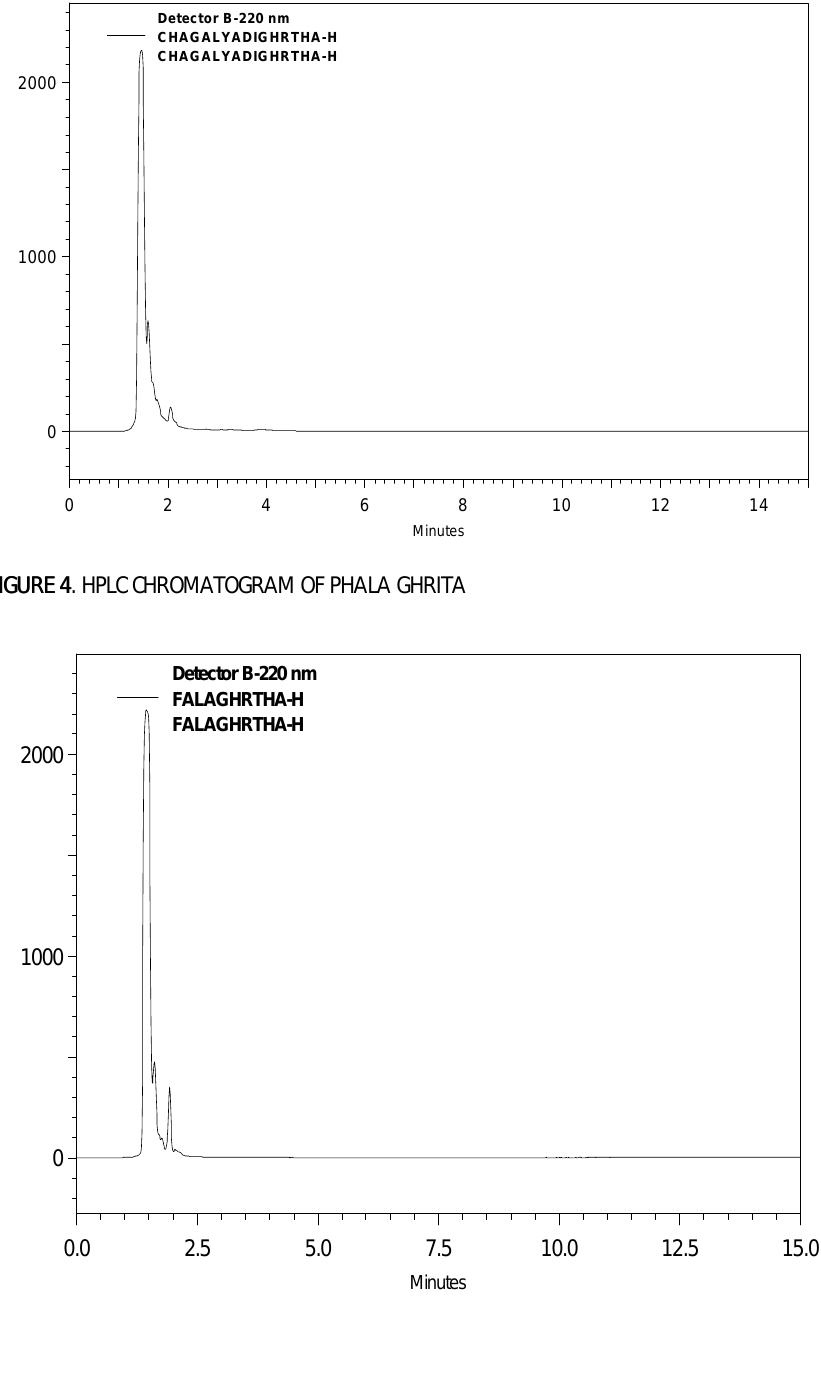
FIGURE 3FIGURE 3. HPLC CHROMATOGRAM OF CHAGALYADI GHRITA